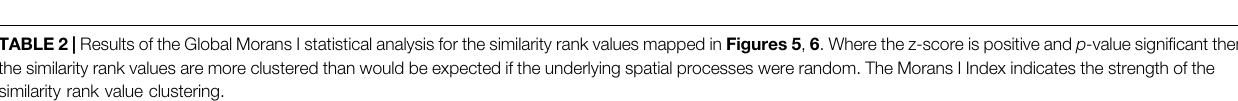
FIGURE 6 | As per Figure 5 , but showing the results of the similarity analysis based on the NAO/EA SSI-1 correlation time series.